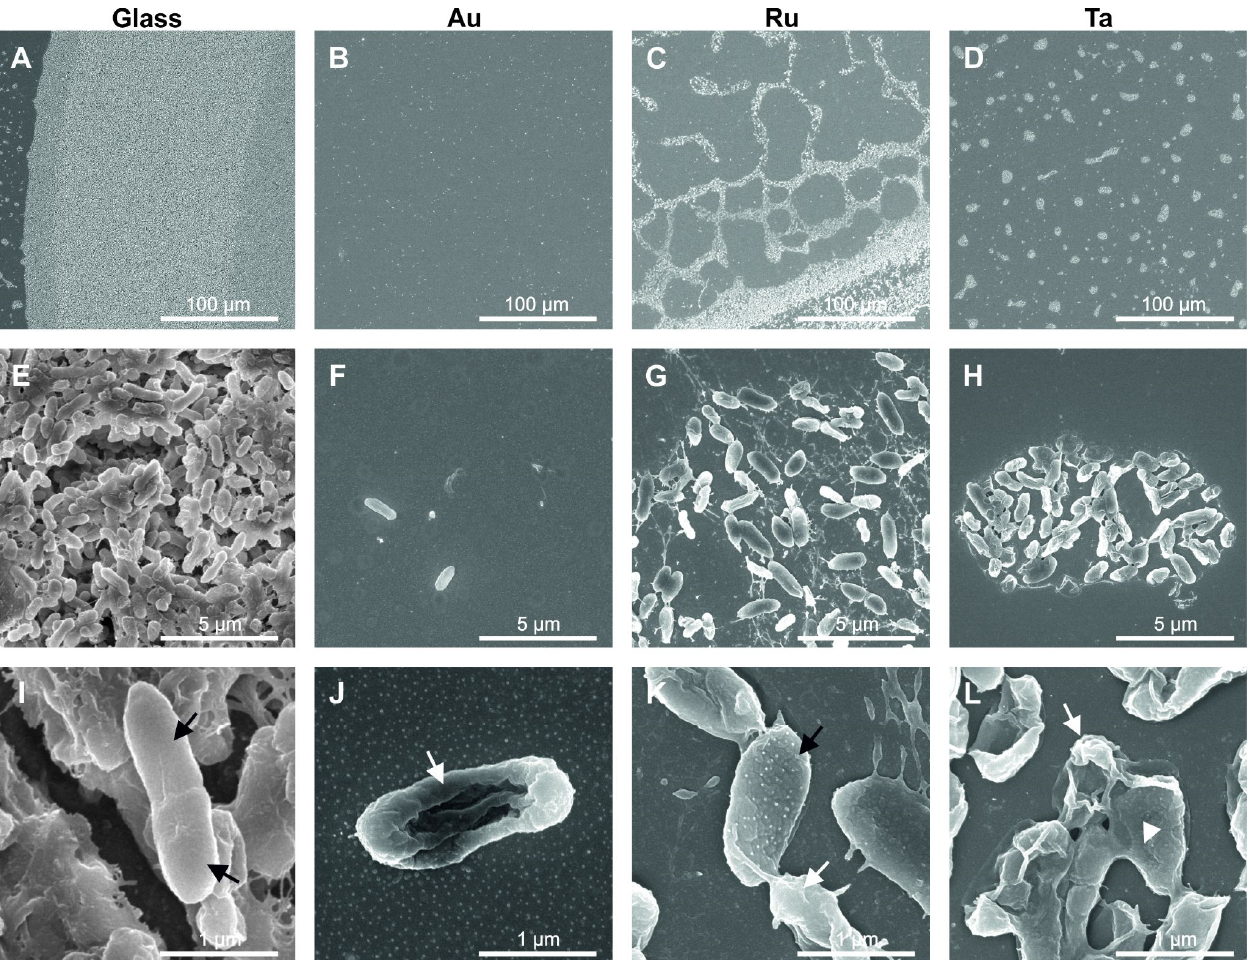
Figure 4. SEM images of Pseudomonas aeruginosa grown for 24 h on glass, gold, ruthenium and tantalum surfaces. The first row ( A – D ) shows an overview of bacterial growth on the different sur- faces. On the glass control surface a vital bacterial biofilm is formed ( A ), whereas on the metal-coated surfaces a clear growth inhibition is visible ( C , D ). In the second row ( E – H ) a higher magnification is shown, revealing a healthy horizontal biofilm on glass ( E ) in contrast to single-spaced-out bacteria on gold ( F ) and remains of bacterial groups on ruthenium ( G ) and tantalum ( H ). High-resolution images are depicted in the last row ( I – L ). In the vital biofilm on glass a dividing bacterium is highlighted by black arrows ( I ). Metal coatings induced bacterial death, see white arrows ( J – L ). A biofilm slime residue is displayed by a white arrowhead on tantalum (( L ), white